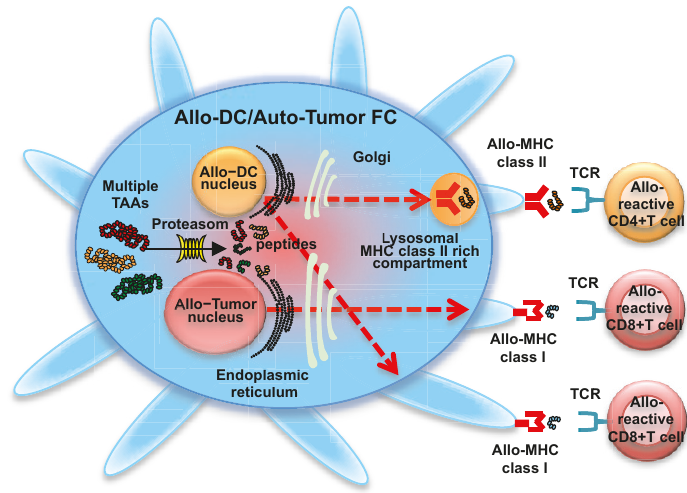
Figure 4. Fusion cells generated with allogeneic dendritic cells and allogeneic tumor cells. Fusions of allogeneic dendritic cells (Allo-DCs) and allogeneic tumor cells (Allo-DC/Allo-Tumor FC) display a characteristic phenotype comprised of MHC class I molecules from allogeneic DCs and allogeneic tumor cells, MHC class II molecules from allogeneic DCs, co-stimulatory molecules (CD80 and CD86), and multiple tumor-associated antigens. Multiple tumor-associated antigens from allogeneic tumor cells are degraded by proteasome in Allo-DC/Allo-Tumor FC (solid line arrow), and antigenic peptides are loaded onto MHC class I molecules from allogeneic DC (red-colored dash line arrow) and allogeneic tumor cell (red-colored dash line arrow) in the endoplasmic reticulum. The peptide-MHC class I complexes are then expressed on the Allo-DC/Allo-Tumor FC surface and stimulate alloreactive CD8 + T cells. Allo-DC/Allo-Tumor FC can also synthesize MHC class II-restricted antigenic peptides in the endoplasmic reticulum. These are transported to the cytoplasm, where peptide-allogeneic MHC class II complexes are generated (red-colored dash line arrow). Peptide-allogeneic MHC class II complexes are also expressed on the Allo-DC/Allo-Tumor FC surface and activate alloreactive CD4 + T cells. Moreover, antigens derived from Allo-DC/Allo-Tumor FC are also be cross-presented by host DCs, resulting in the induction of polyclonal antigen-specific CD4 + and CD8 + T